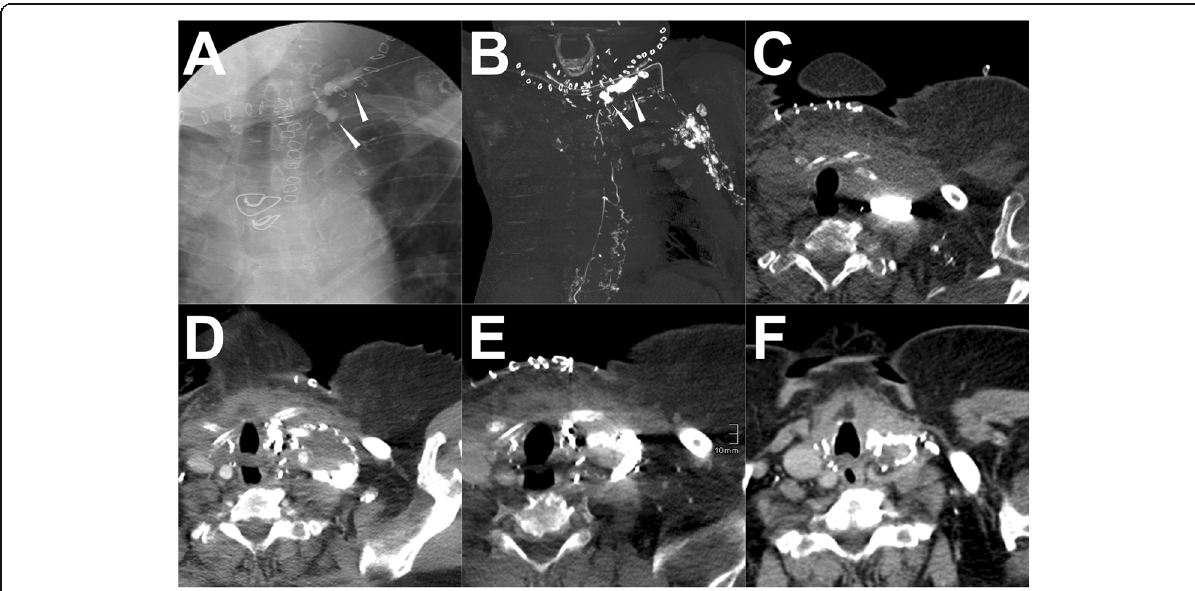
Fig. 9 A patient underwent no interventions after iodized oil-based LAG. Note: Both the conventional iodized oil-based LAG ( a ) and post-LAG CT ( b ) reveal the definite rupture of the thoracic duct (white arrowhead) in the neck. In addition, the reflux of lipiodol to the left axillary and upper arm was observed which indicates the disruption of the end of the thoracic duct ( b ). In the axial post-LAG CT image, the fluid accumulation with the iodized oil extravasation is noticed ( c ). No other intervention was carried out in this patient except for the conventional iodized oil-based LAG treatment. However, with time (6d, 11d) ( d-e ), the fluid accumulation gradually reduced and the drainage eventually ceased on the 11th day. Two (2) months after LAG, the recheck of the CT scan shows no recurrence of the LF ( f ). Abbreviations: LAG – lymphangiography; post-LAG CT – post-lymphangiographic computed